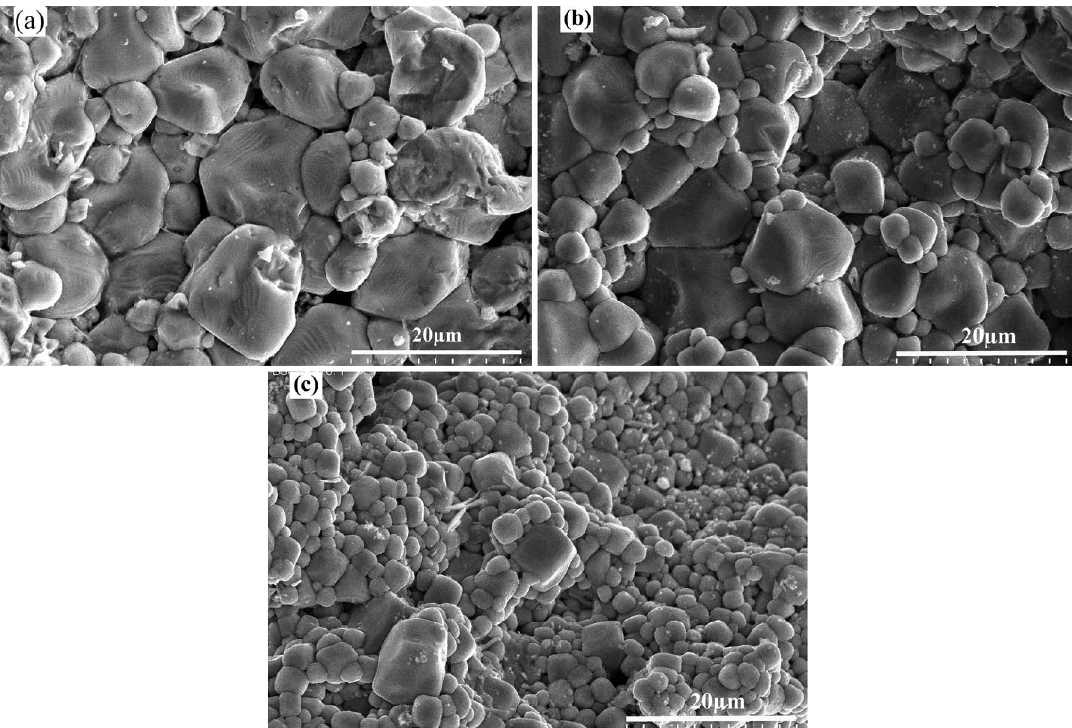
with different content; (a) 0 mol%, (b) 4 mol%, (c) 8 3